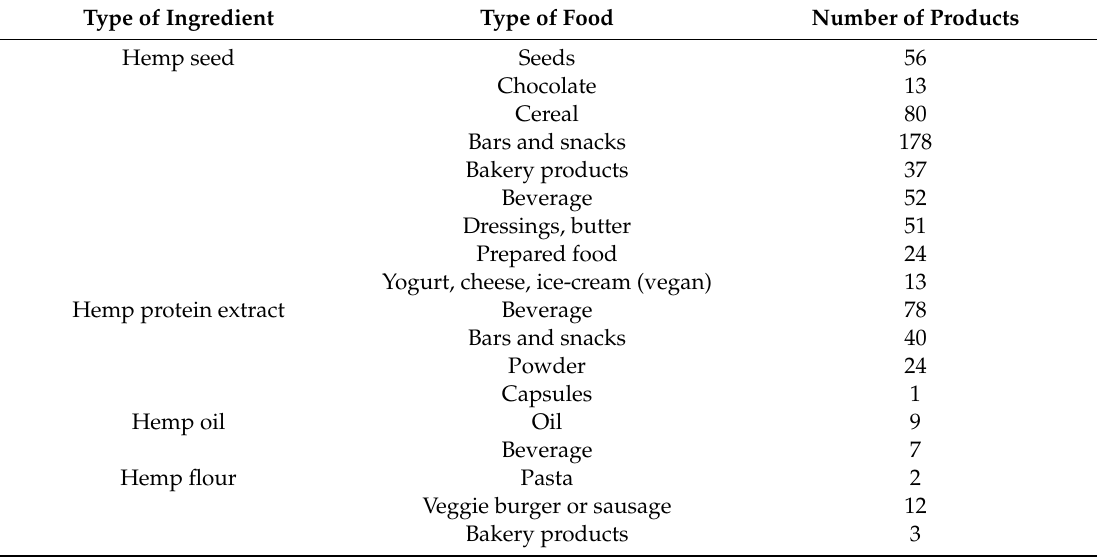
Table 1. Di ff erent uses of hemp seed as a food ingredient. Data obtained from FoodData Central